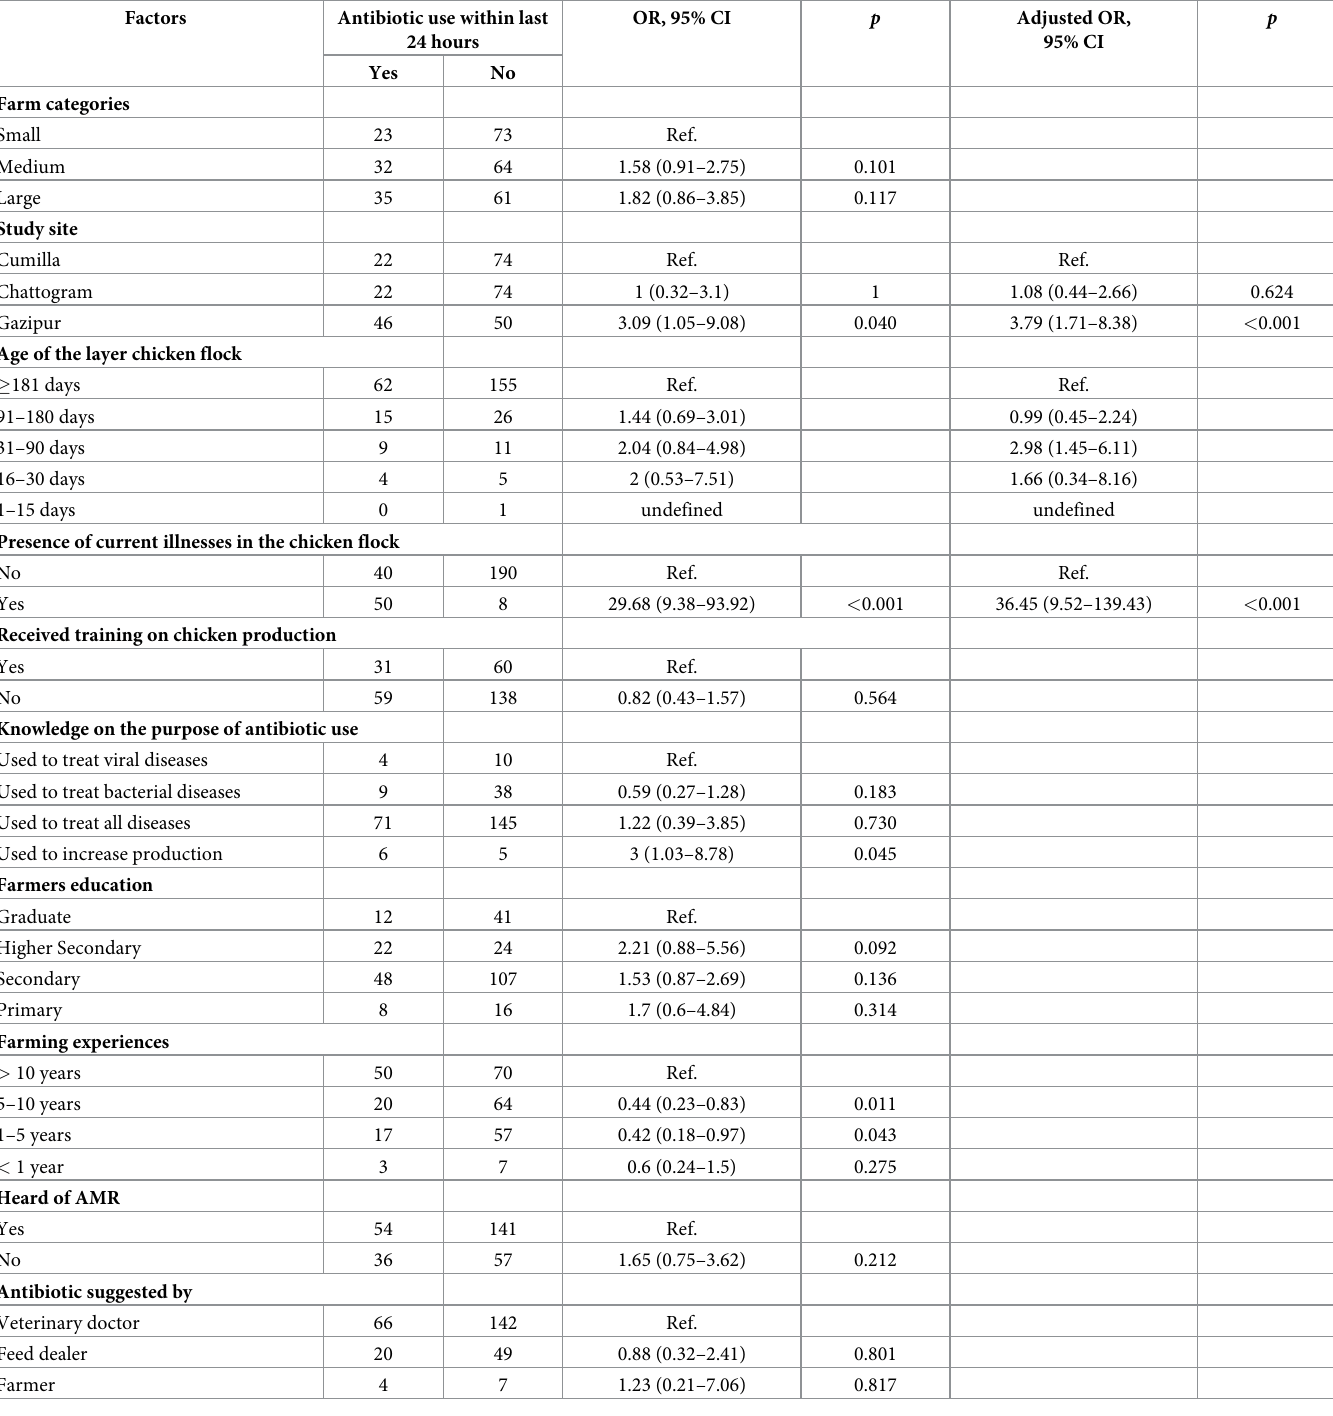
Table 9. Factors associated with antibiotic use in commercial layer farms (N = 288), during January-May 2021,